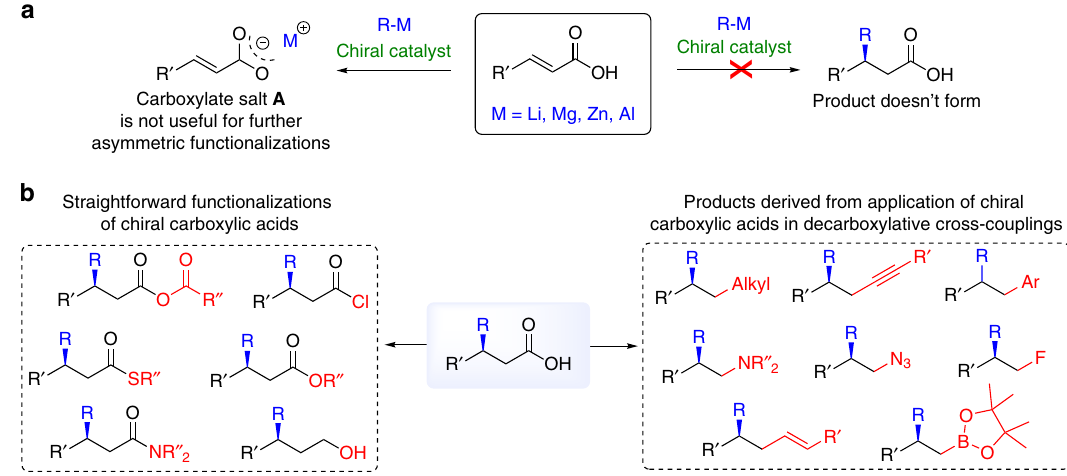
Fig. 1 State of the art in conjugate additions to unsaturated carboxylic acids and potential value of addition products. a Fundamental problem that prevents the development of conjugate additions to unprotected unsaturated carboxylic acids: mixing of organometallics with carboxylic acids leads to an acid – base reaction, resulting in a carboxylate salt A nearly unreactive toward further reactions. b Overview of transformations of the carboxylic acid functional group leading to its chiral derivatives and new structural motives: carboxylic acids can undergo straightforward functionalization and decarboxylative cross- coupling